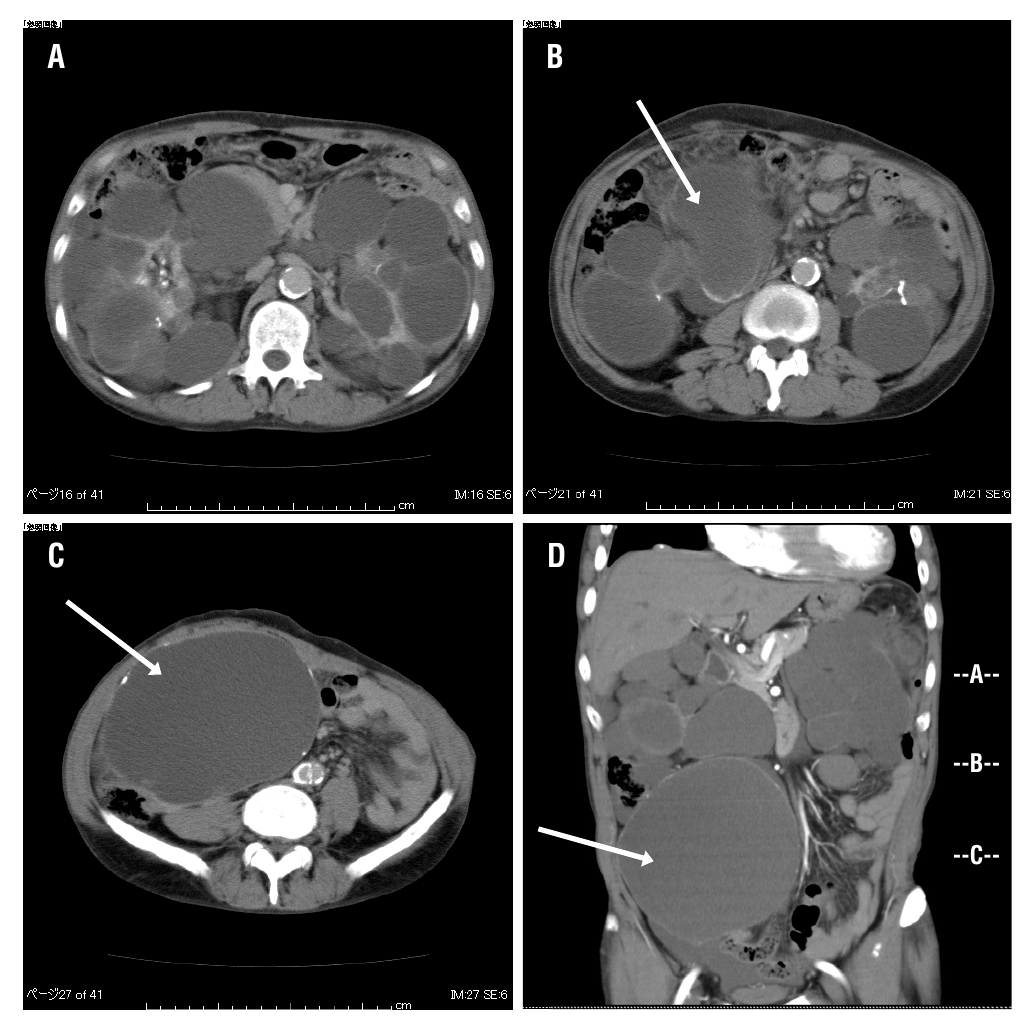
Figure 1 - Contrast-enhanced CT of the abdomen before embolization reveals bilateral polycystic kidneys, with the largest cyst (arrow) occupying the right lower quadrant of the abdomen. a-C) axial views at different levels. d) Coronal